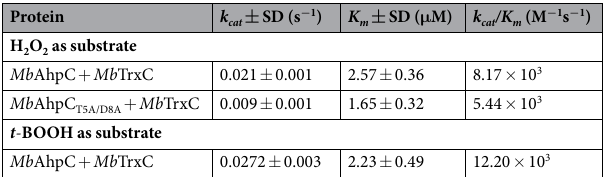
Table 1. Kinetic parameters of mycobacterial AhpC with TrxC and NADPH.